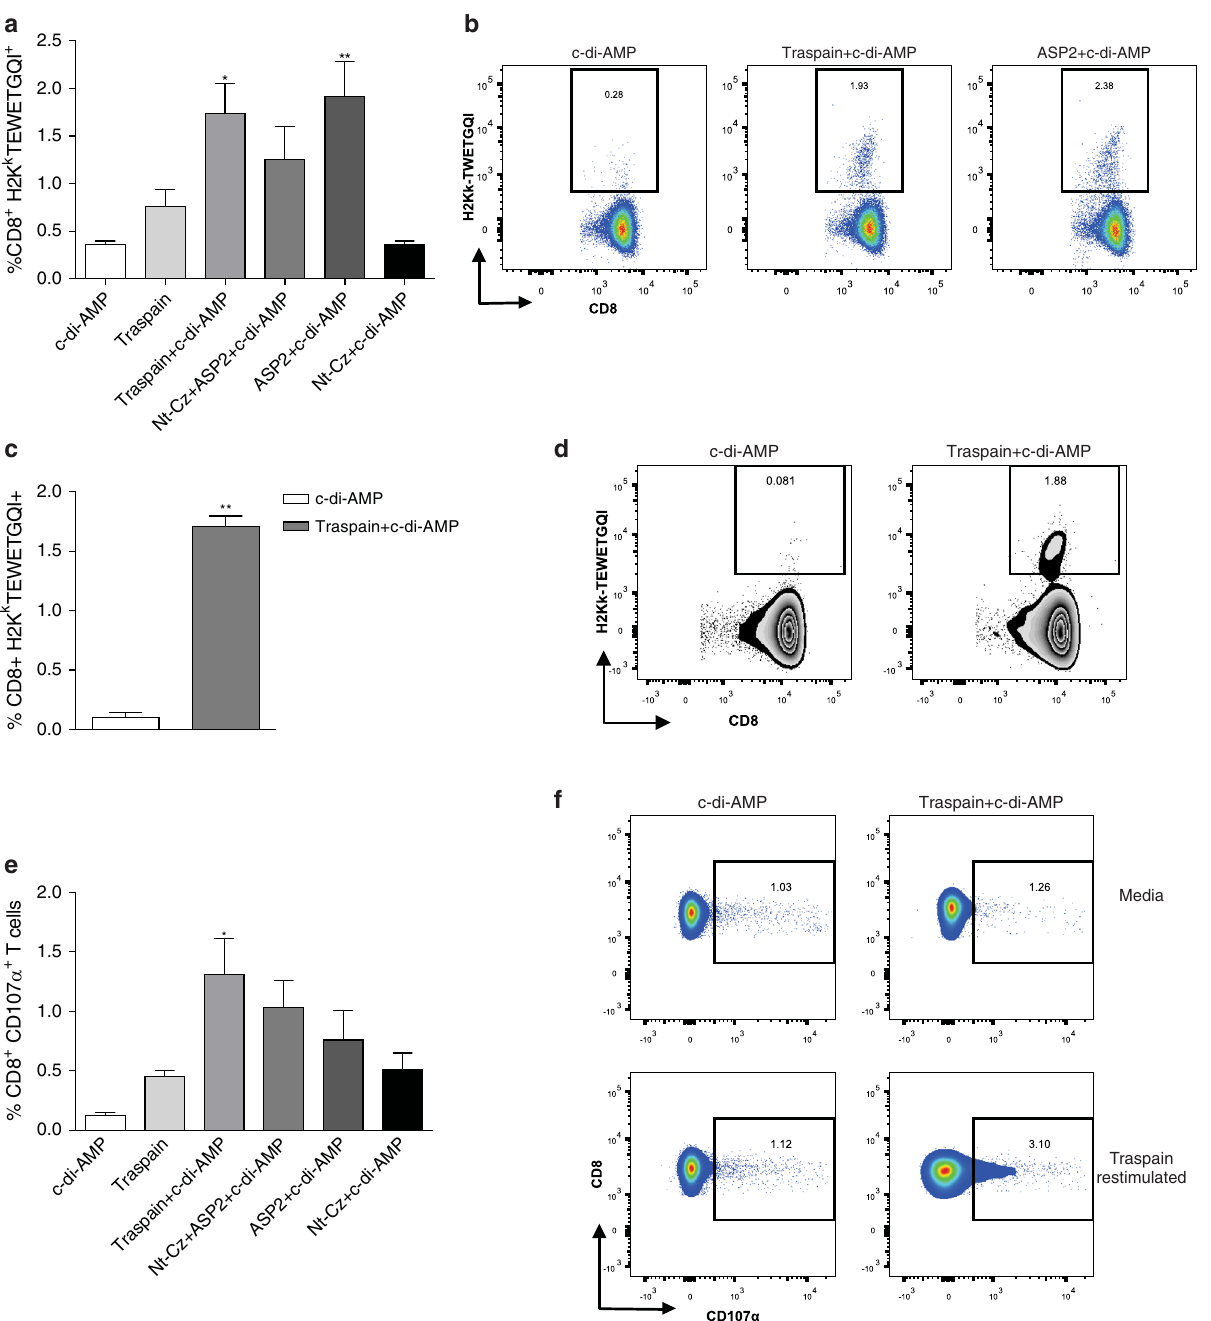
Fig. 4 CD8 + T cell mediated immune responses of immunized mice. Priming of pathogen-speci fi c CD8 + T cells by vaccination at 30 dpi ( a ). Representative dot-plots for the indicated groups ( b ). Levels of circulating pathogen-speci fi c CD8 + T cells in blood for Traspain+c-di-AMP vaccinated and control mice ( c ) and representative zebra-plots of each group ( d ). Frequency of CD107 α + CD8 + T cells calculated upon antigen re-stimulation of spleen cells from each group ( d ). Representative dot-plots of the indicated groups ( e ). Results are expressed as mean ( a , c ) or subtracted mean ( e ) ± SEM and are representative of two independent experiments, n = 4 per group. ** p < 0.01, * p < 0.05, one-way-ANOVA + Bonferroni multiple comparisons test ( a , e ). ** p < 0.01 Mann – Whitney test ( c